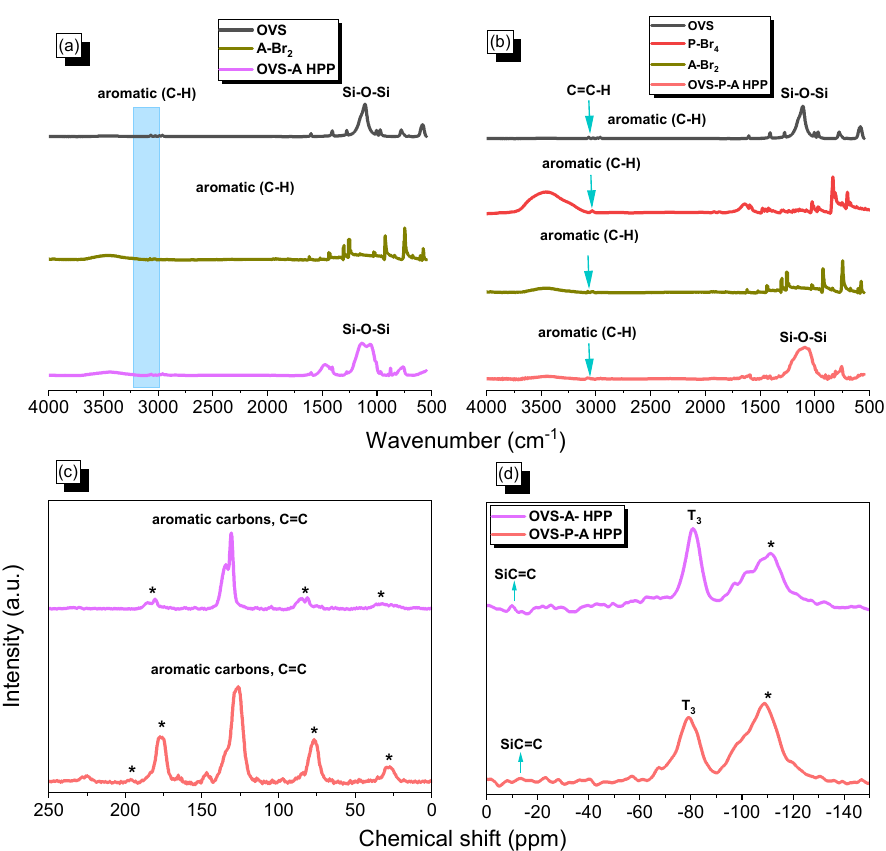
Figure 1. ( a , b ) FTIR of OVS, A-Br 2 , P-Br 4 , OVS-A HPP and OVS-P-A HPP, ( c ) 13 C and ( d ) 29 Si NMR spectra of the OVS-A HPP and OVS-P-A HPP. * is the side band of solid-state nuclear magnetic resonance spectroscopy (NMR). O, and C elements in OVS-A HPP and OVS-P-A HPP (Figure 2). We observed Si2p, Si2s, C1s, and O1s signals corresponding to 103 eV, 155 eV, 284 eV, and 532 eV for OVS-A HPP, respectively (Figure 2a), and 103 eV, 156 eV, 284 eV and 534 eV for OVS-P-A HPP, respec- tively (Figure 2b). XPS analysis confirmed the successful synthesis of OVS-A HPP and OVS-P-A HPP materials.